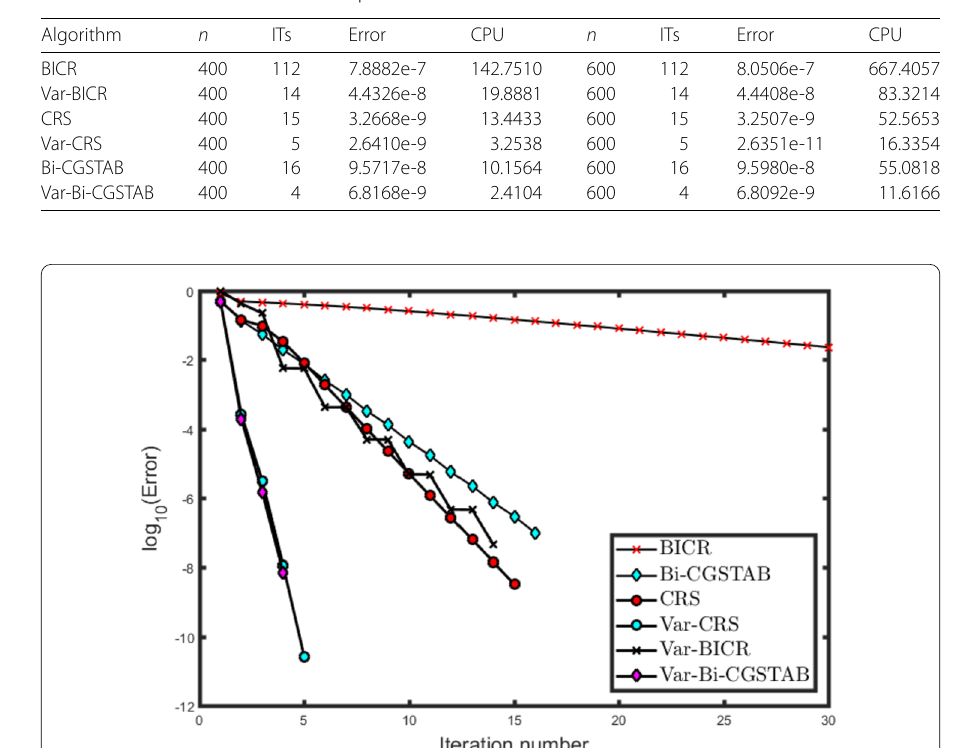
Figure 1 Comparison between the residual error of Algorithms 1 to 6 for Example